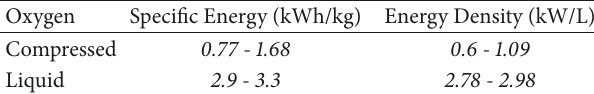
Table 2: Oxygen storage system for SE and ED. Oxygen Specific Energy (kWh/kg) Energy Density